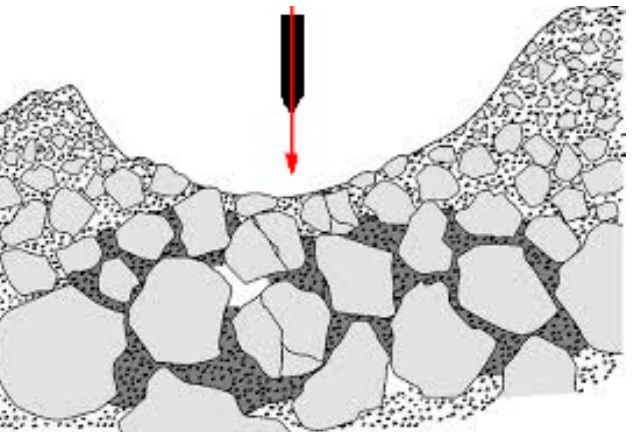
Figure 1. Schematic illustrating the surface of a rubble pile asteroid (and the projectile approaching to hit that surface).